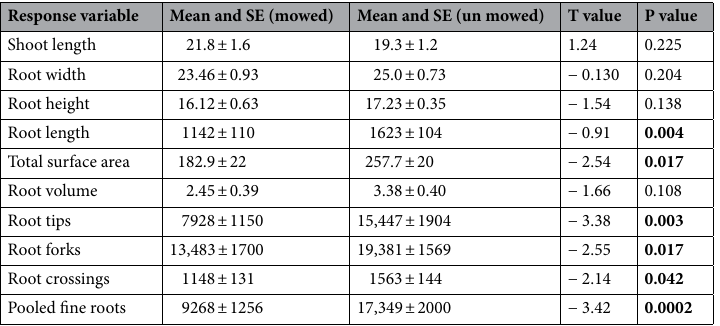
Table 1. Details of response variables, treatment means, statistical tests and significance from WinRhizo experiment. Variables that are statistically significant are in bold P values at P <